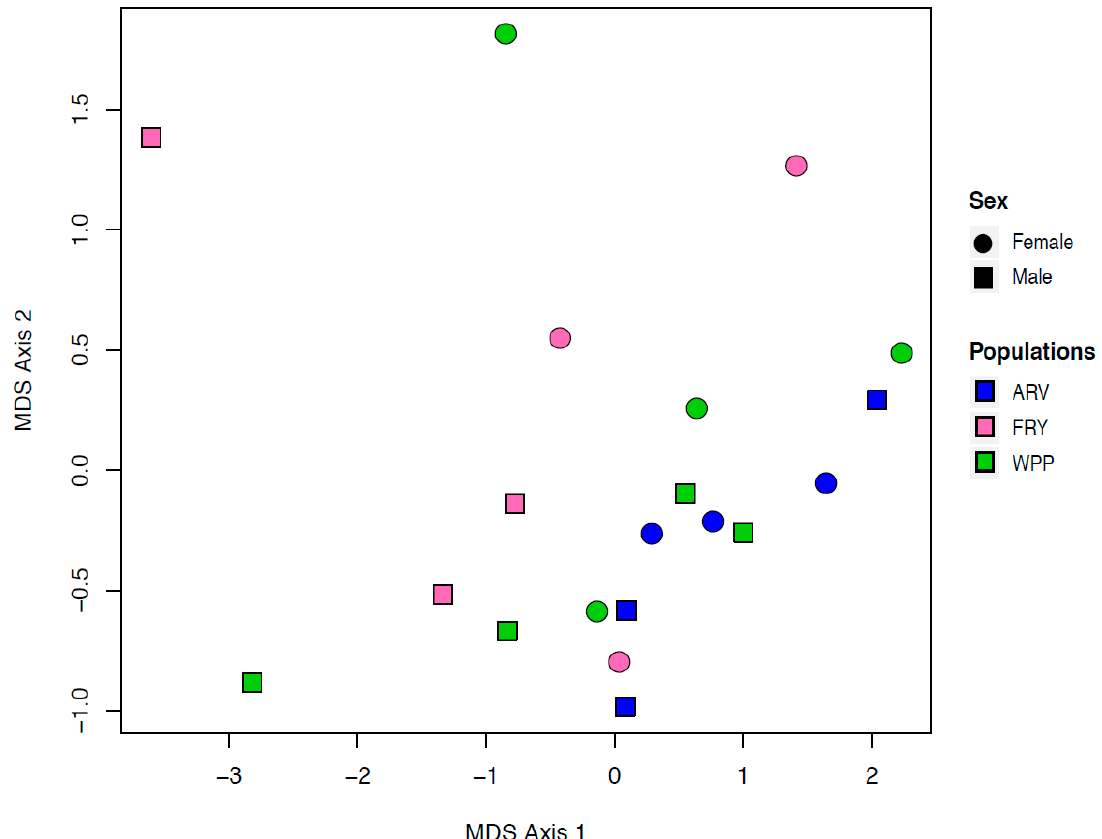
Figure 2. Multi-dimensional scaling (MDS) plot displaying similarity among the samples based on transformed count data. There is no discernible clustering based on sex (circles for females and squares for males) or geographic location.